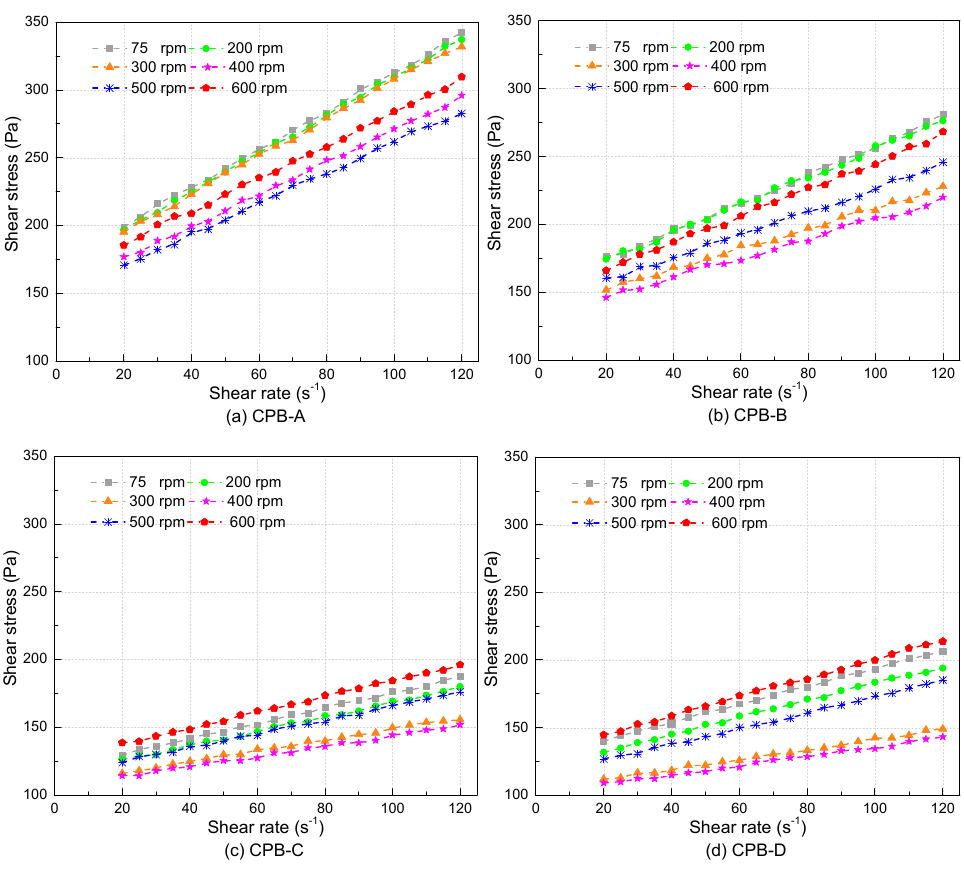
Figure 7. Influence of mixing speed on flow curve behaviors depending on different CPBs: ( a ) CPB-A; ( b ) CPB-B; ( c ) CPB-C; and ( d ) CPB-D.